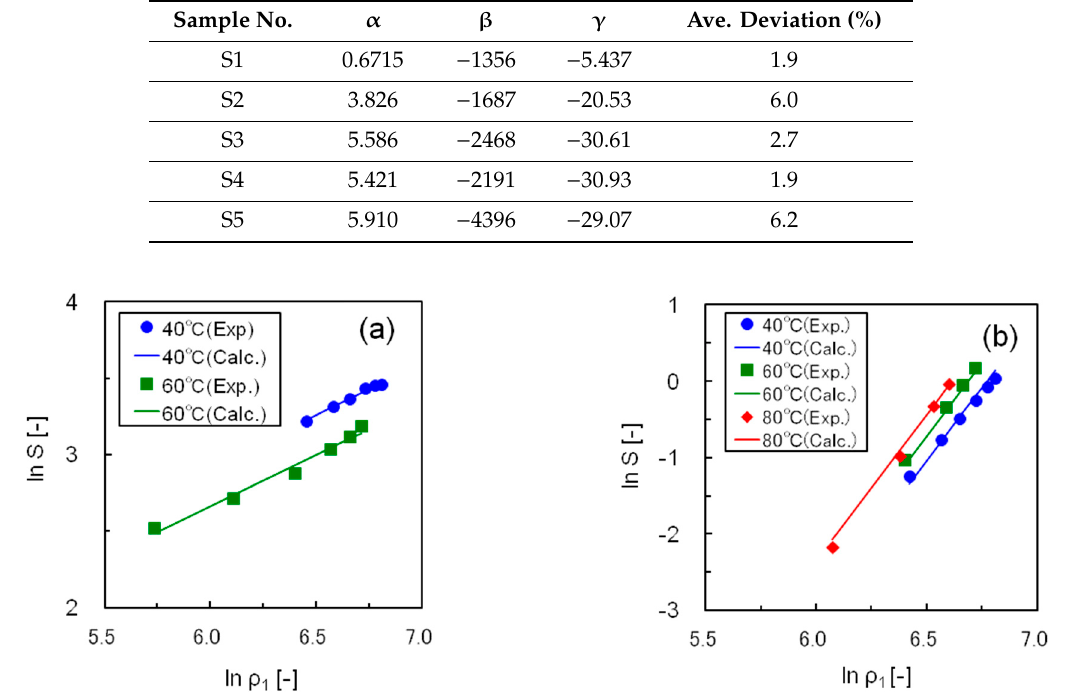
Figure 7. Correlating the solubility data for silicone resins using Chrastil’s equation ( a ) Resin S1; ( b ) Resin S2.